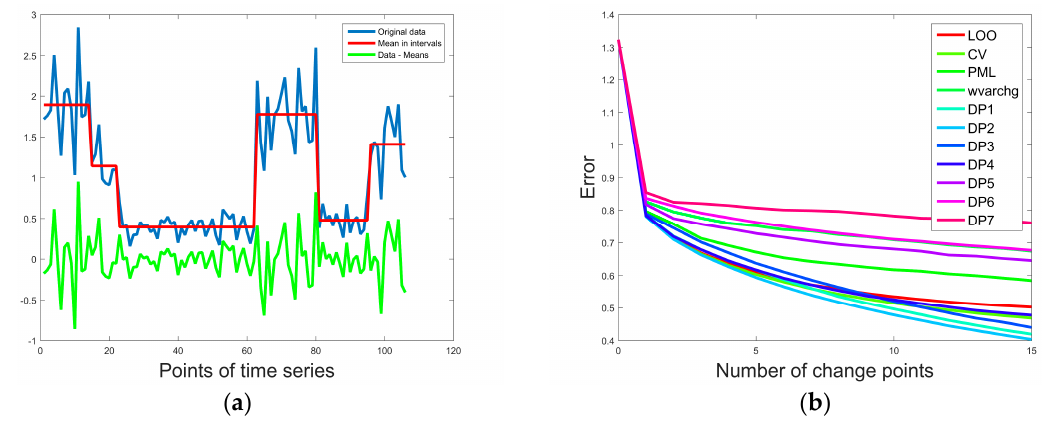
Figure 2. Results of the analysis of random time series using our online quality control (QC) tool: ( a ) marked mean values in the intervals between change-points and residuals computed as differences between original data points and means in the corresponding time intervals; ( b ) relation between the error (computed using Equation (4)) and the number of change points obtained using various methods.